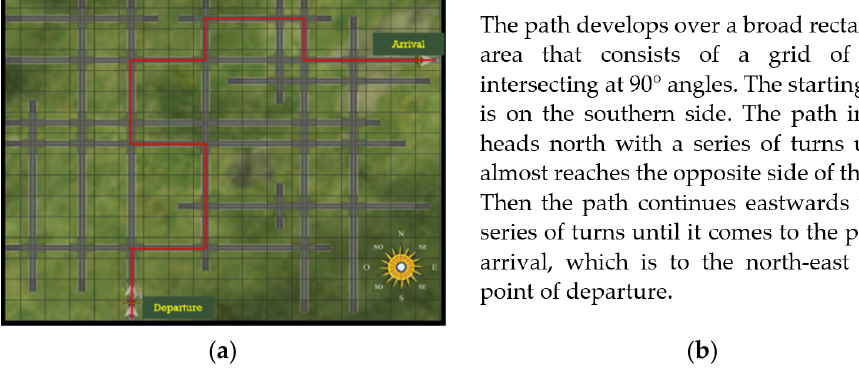
Figure 2. ( a ) The map studied by the “map before navigation” group; ( b ) the description of the environment read by the “description before navigation” group.